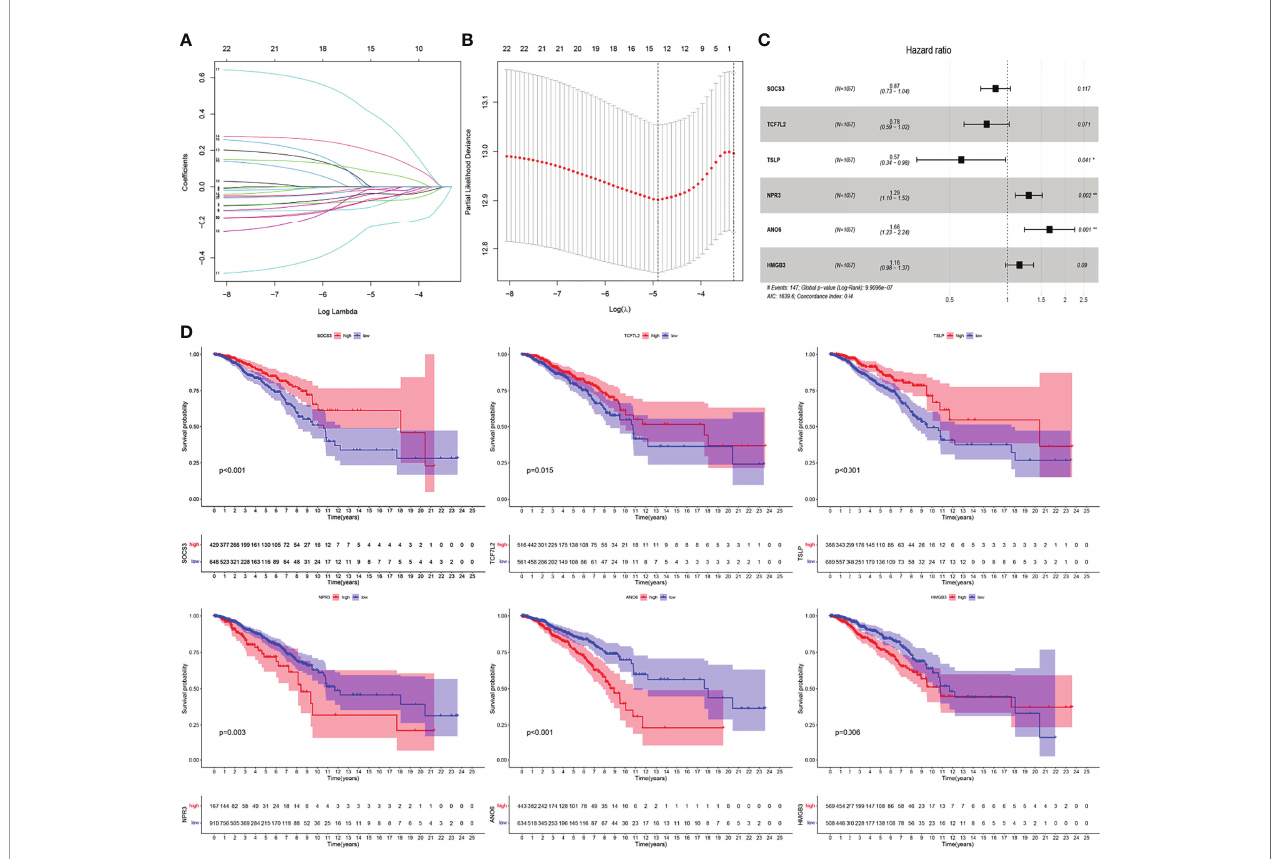
FIGURE 3 | Construction of immune-related prognostic index (IRGPI) for BC. (A) LASSO coef fi cient pro fi les of the IRGs associated with disease-free survival of BC. (B) Plots of the cross-validation error rates. Each dot represents a lambda value along with error bars that represent the con fi dence interval for the cross-validated error rate. (C) Forest plots of hazard ratios (HR) of survival-associated IRGs obtained using multivariate Cox regression analysis. (D) K-M survival curves of 6 genes. * P < 0.05, ** P <